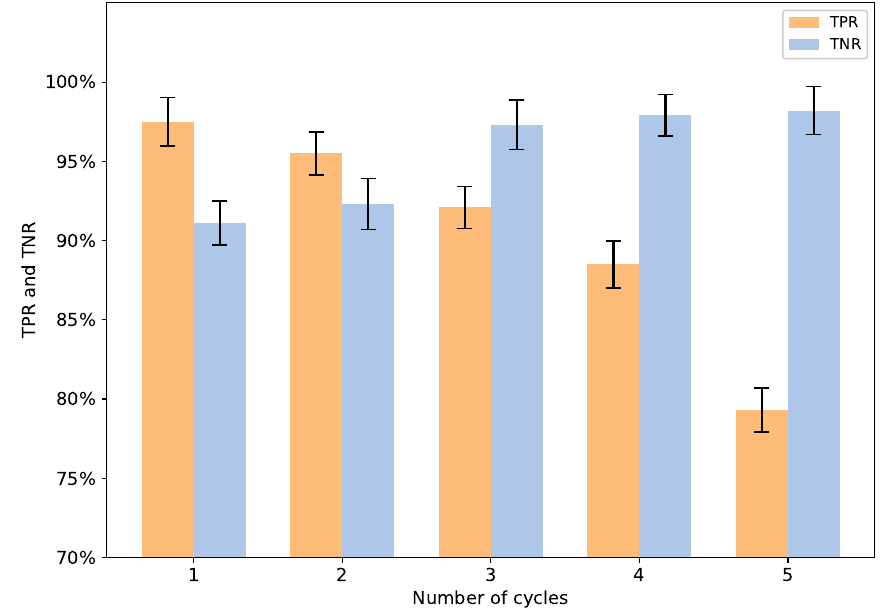
Figure 7. The true positive rate and the true negative rate under different number of